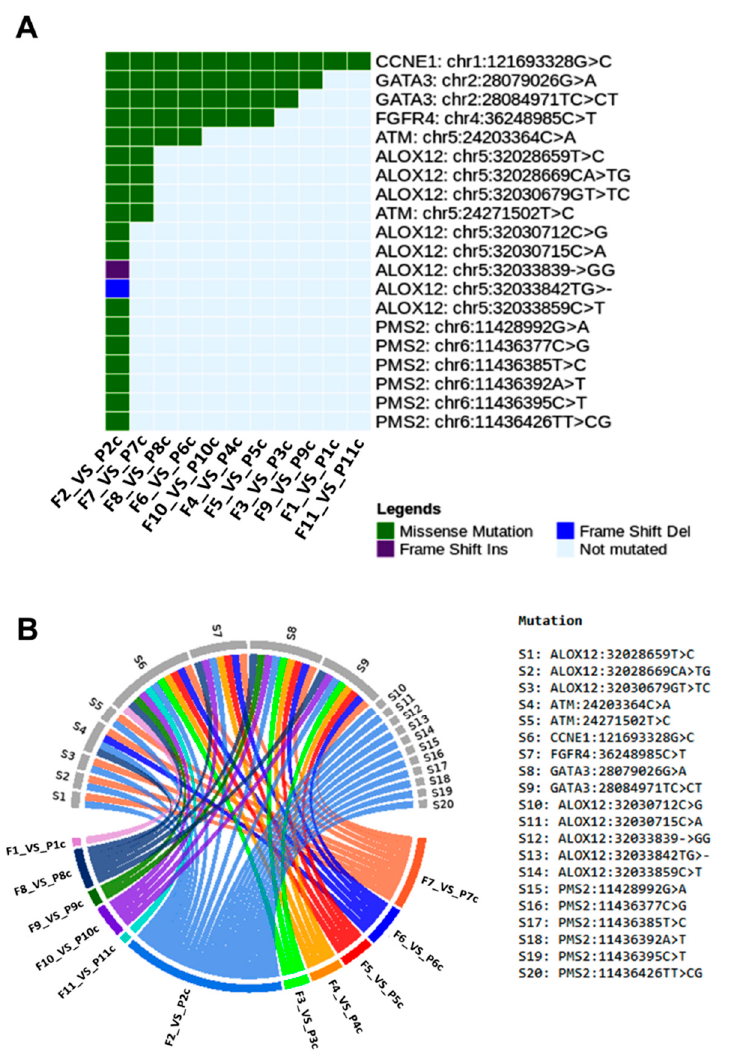
Figure 9. Genetic mutations shared by tumor fragments and plasma samples of dogs. ( A ) Common genetic variants in 11 corresponding samples. ( B ) Circos plot depicting the correlation between samples and gene variants in female dogs. Graphics were generated from the R language, using the Maftools, circlize, dplyr and reshape2 packages.